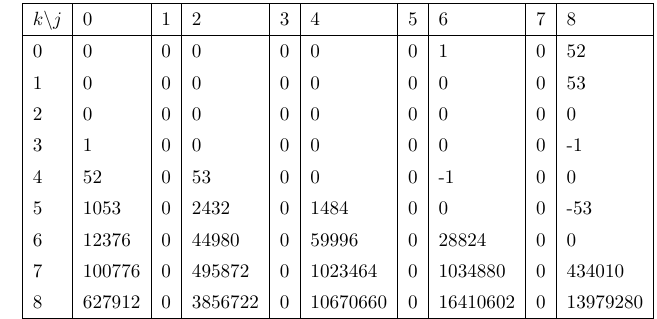
Table 83. Table of b jk coe(cid:14)cients for h F 4